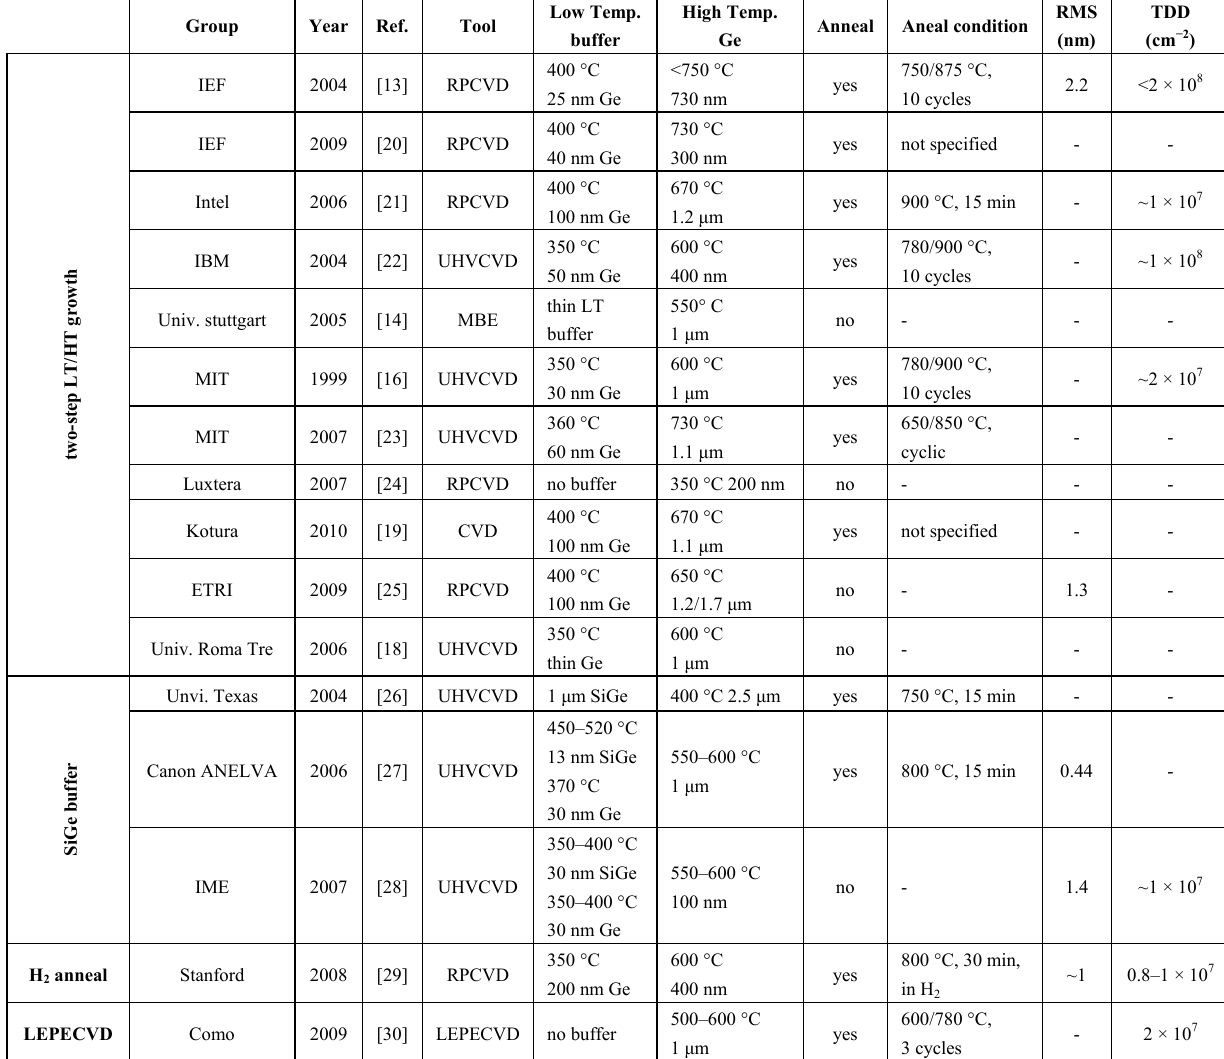
Table 1. Summary of recent Ge epitaxy method from selected